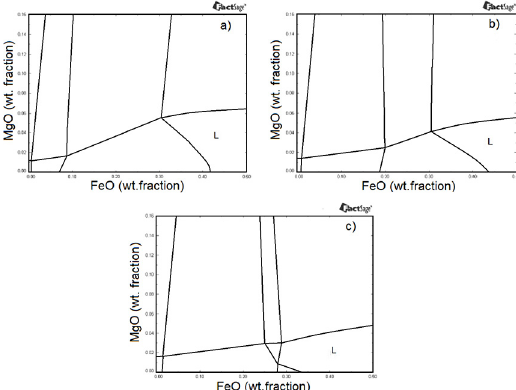
Figure 9: Isothermal saturation diagrams for different basicities (a) B =2.0; (b) B =2.5; (c) B =3.0. 2 2 2